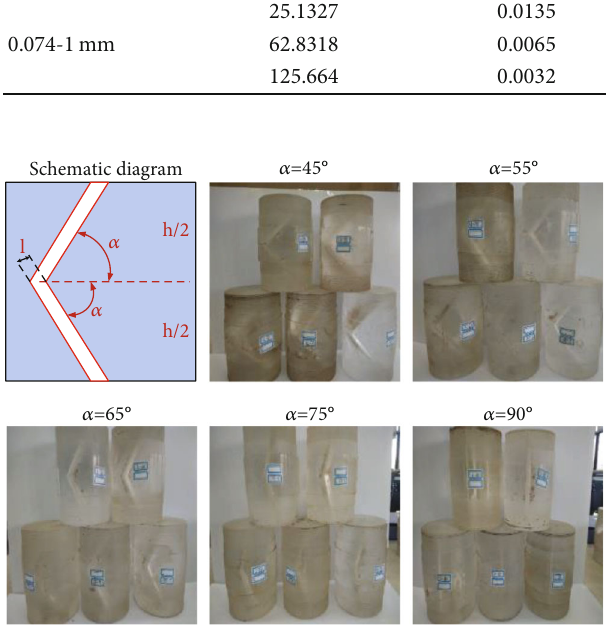
Figure 5: Schematic diagram and actual fracture test pieces. l , h , and α are the fracture aperture, height, and fracture angle of the sample,